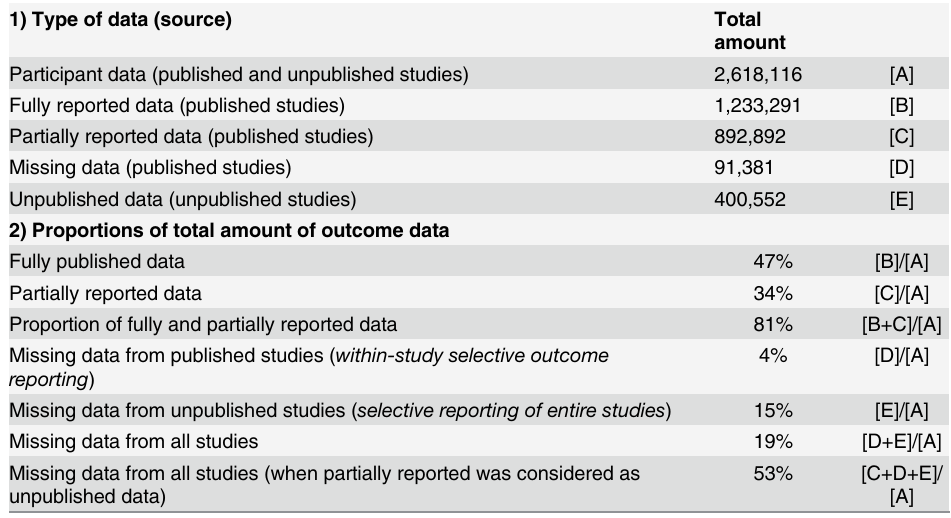
Table 2. Proportion of reported and missing participant outcome